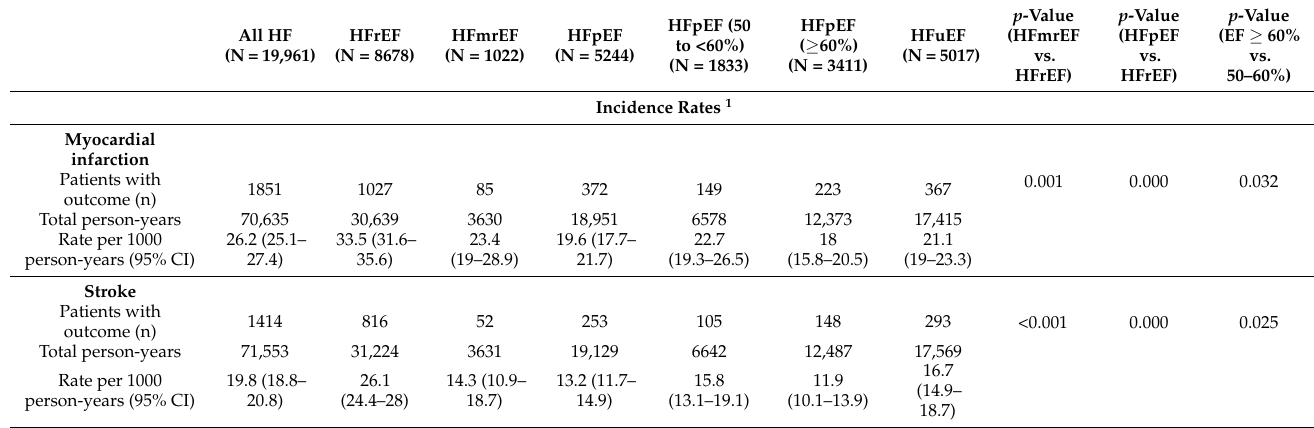
Table 3. Rates of adverse clinical outcomes in the incident HF